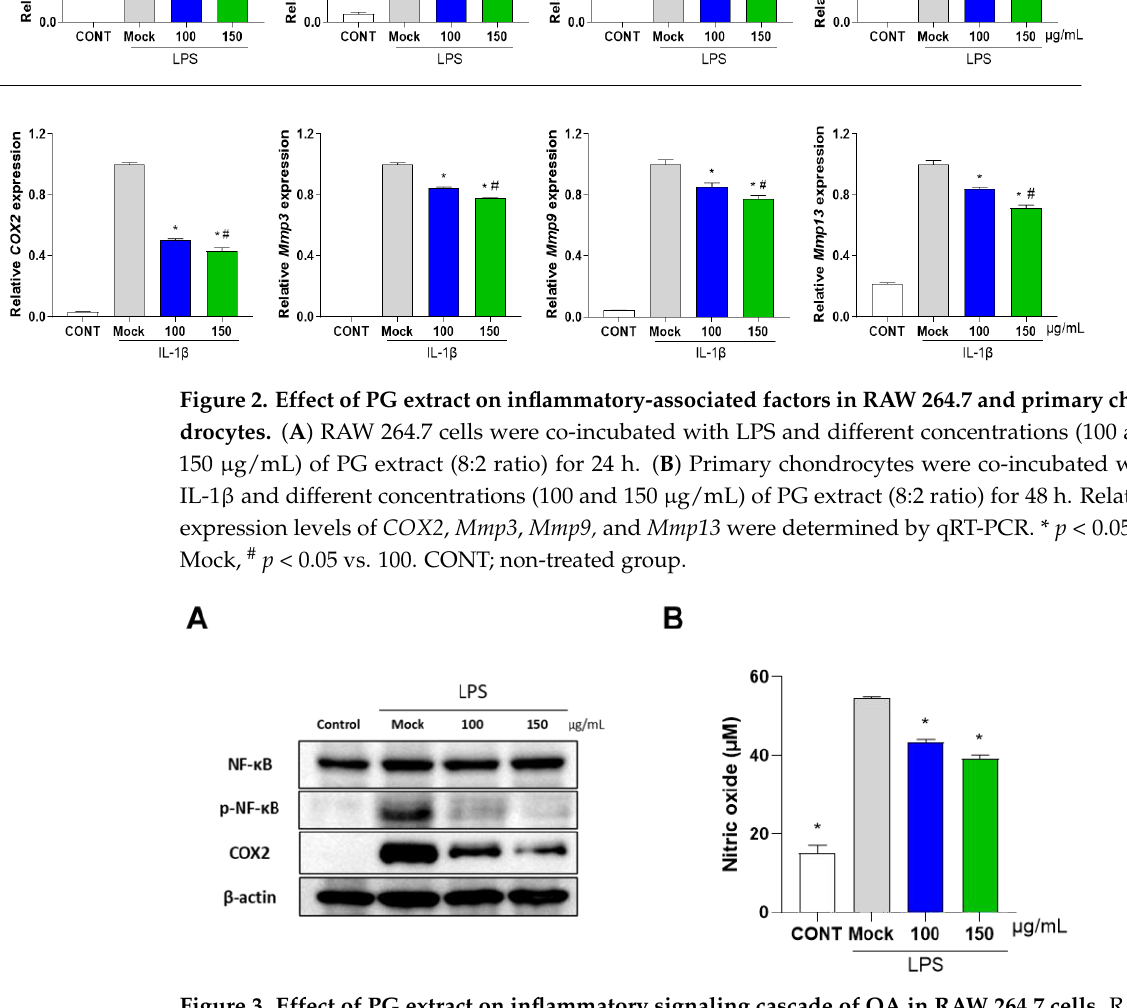
To further confirm the anti-inflammatory effect of PG leaf extract on destructive mediators, the levels of secreted PGE2 and collagenase were investigated in IL- 1β -induced primary chondrocytes. The administration of IL- 1β and co -treatment with PG extract (100 and 150 µg/mL)induced inflammation of primary cultured chondrocytes. To measure the release of PGE2 and collagenase, the culture supernatant was concentrated using Vivaspin ® , and the levels of destructive mediators were analyzed using an enzyme-linked immunosorbent assay (ELISA) kit. IL- 1β -induced primary chondrocyte s exhibited increased PGE2 and collagenase levels. However, treatment with the PG extract significantly suppressed the secretion of PGE2 and collagenase in IL- 1β -induced chondrocytes. (Figure 4A,B). These results indicate that PG treatment inhibited the secretion of PGE2 and collagenase by downregulating the COX2, Mmp3, Mmp9, and Mmp13 expressions. Figure 4. Effect of PG extract on destructive mediators in IL- 1β induced primary chondrocyte inflammation. Primary cultured mouse chondrocytes were incubated with different concentrations